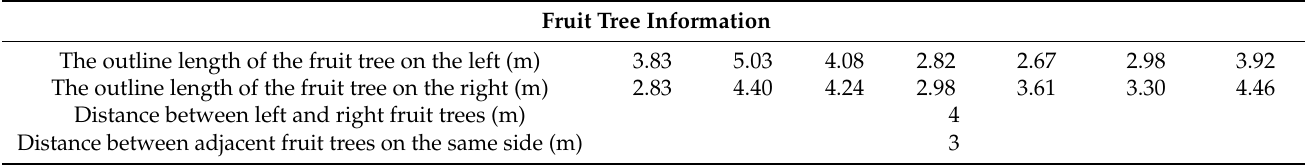
Figure 6. A frame of preprocessed data. When using the 2D-ICP algorithm to construct point cloud data of fruit trees on both sides of the test platform, we need to consider two problems. The first question is how to obtain as much complete point cloud data as possible. The second problem is how to pre- vent the oscillation of the collected point cloud data due to the uneven ground of the or- chard during movement. Therefore, on the one hand, we move the test platform as slowly as possible, so the vibration amplitude of the vehicle is not large in the process of moving. On the other hand, we choose a 2D LiDAR sensor with a high frequency, as shown in Table 1, to obtain more fruit point cloud data within a short period of time. Through these two measures, the adverse effects caused by the vibration of the test platform can be com- pensated for to a certain extent, and the obtained fruit tree point cloud information can be enriched, which is conducive to obtaining better point cloud registration results.